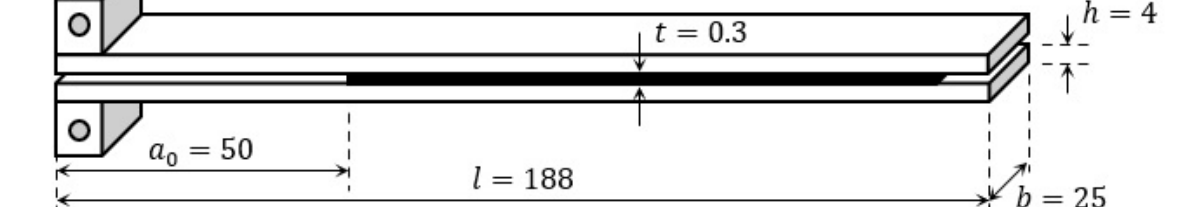
Figure 2. Geometry of a DCB test specimen.